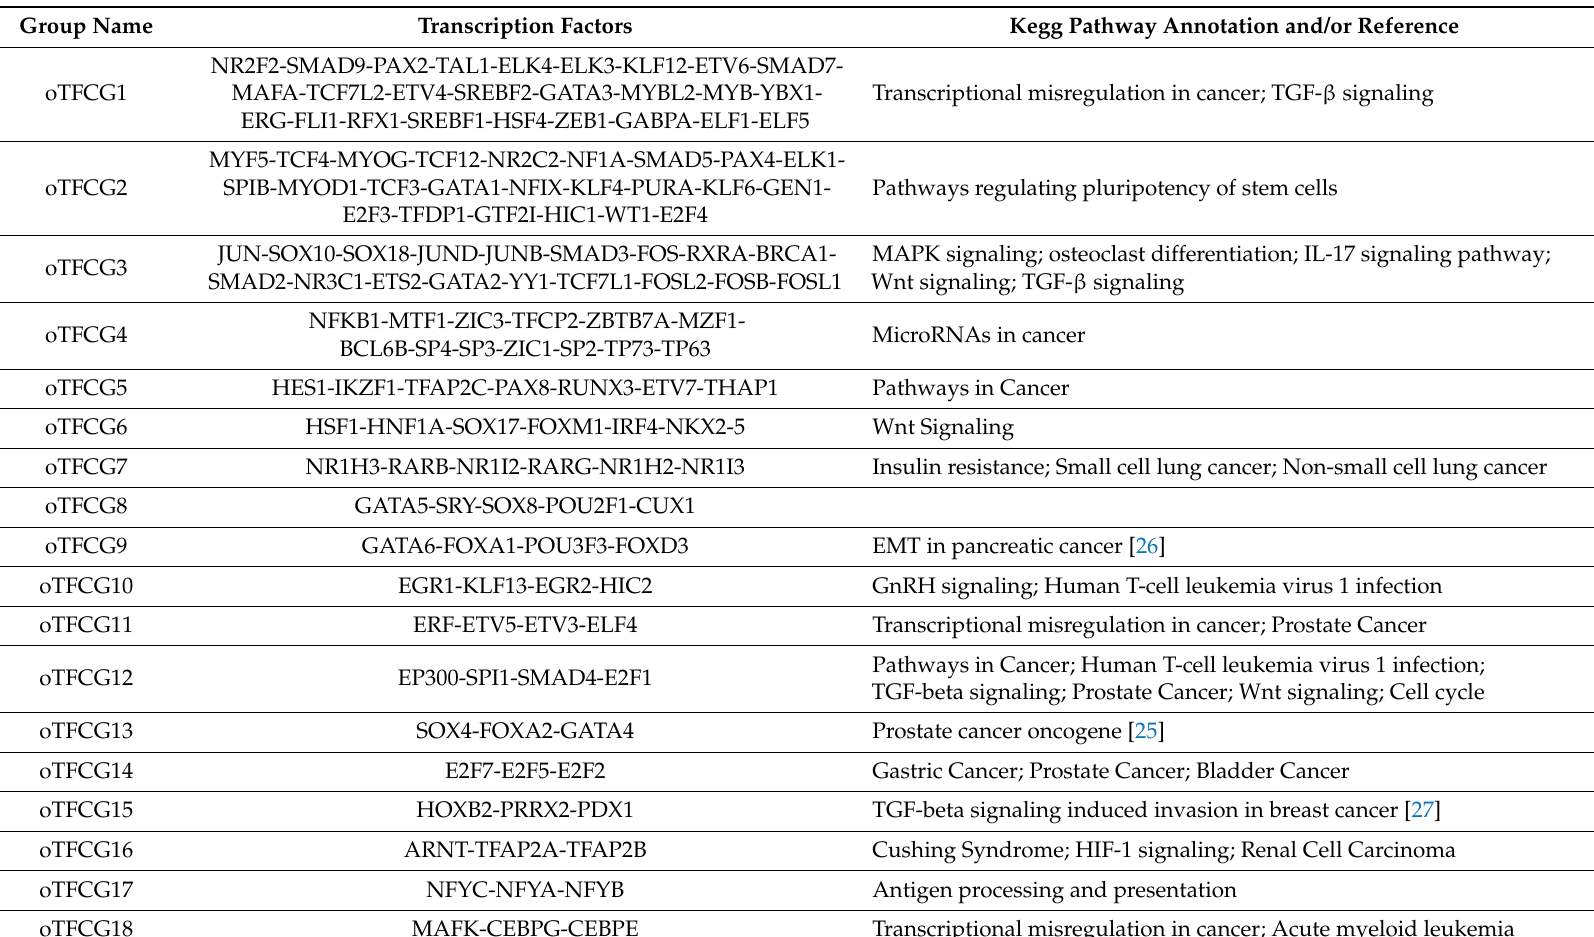
Table 1. Thirty-three overlapping TFCGs (oTFCGs) between the high impact ADT group and Met.PCS1 networks. Annotations are derived from the KEGG pathway database and/or the primary